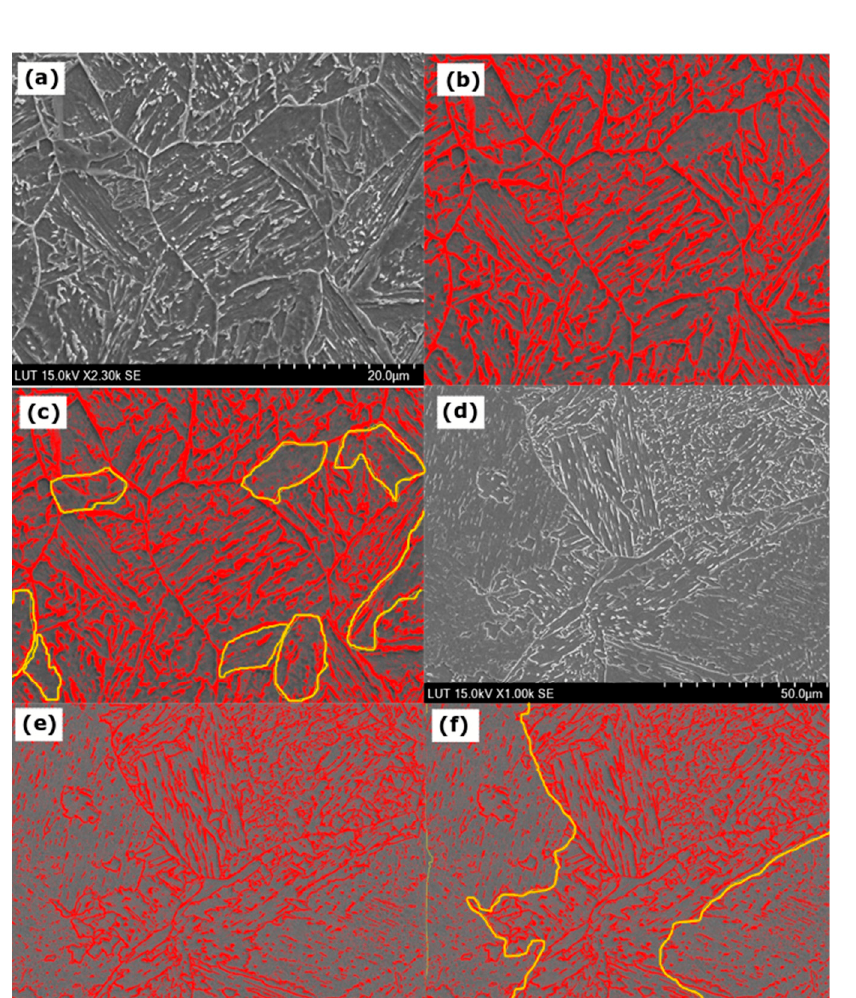
Figure 10. Evaluation of the volume fraction of bainite (B), martensite (M), retained austenite (RA), and ferrite using ImageJ Pro software: ( a ) original SEM image of S700MC, ( b ) darker area to measure B, red area to measure the volume fraction of ferrite, and cementite, ( c ) geometries of RA areas to measure the volume fraction of RA, shown in yellow, ( d ) original SEM image of S960QC, ( e ) darker area to measure the B volume fraction and red zone to measure the volume fraction of ferrite, and ( f ) geometries of the M areas to measure M, shown in